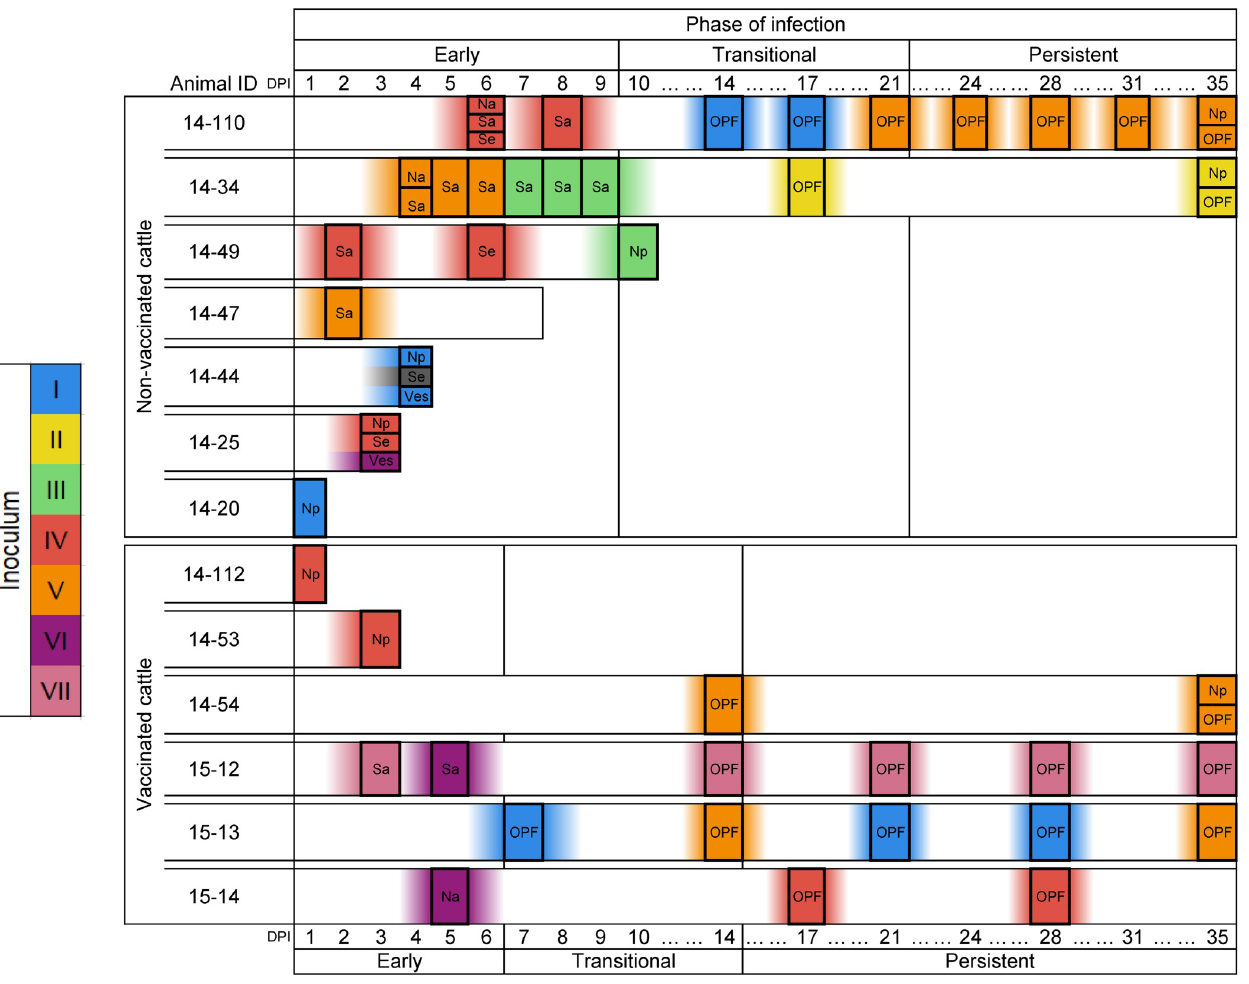
Fig 4. Consensus virus identity across infection. Boxes along each animal’s timeline indicates a virus sample. Colors and associated Roman numerals indicate clades based on inferred phylogenetic relationships (see Fig 4). Inoculum at left has been hypothesized as the source of the seven variant viruses detected. Abbreviations: DPI–days post-infection, Na–nasal secretion, Np–nasopharyngeal tissue (necropsy), OPF–oropharyngeal fluid (probang cup sample), Sa–saliva, Se–serum, Ves–epithelial vesicle. Three phases of FMDV infection were used to define progression of infection in individual animals: early, transitional, and persistent periods; temporal boundaries for the phases differ in vaccinated and non-vaccinated animals, as described in methods.